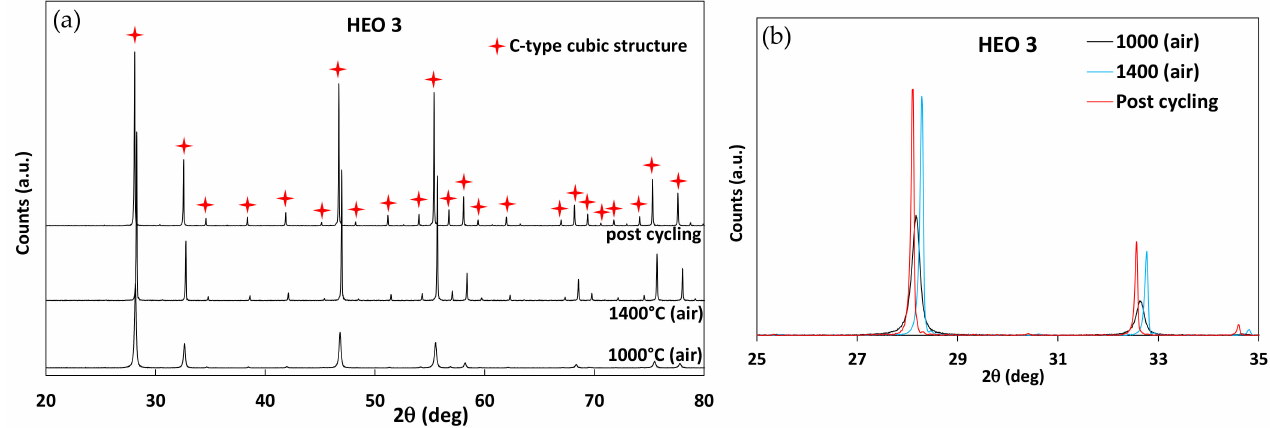
Figure 5. XRD analysis of (Ce 0.2 La 0.2 Pr 0.2 Sm 0.2 Y 0.2 ) 2 O 3 after different heat treatments (annealing in air during 1 h or thermal cycling): ( a ) complete diffractograms; and ( b ) zoom. The lattice parameter (a) was calculated using the Bragg Equation